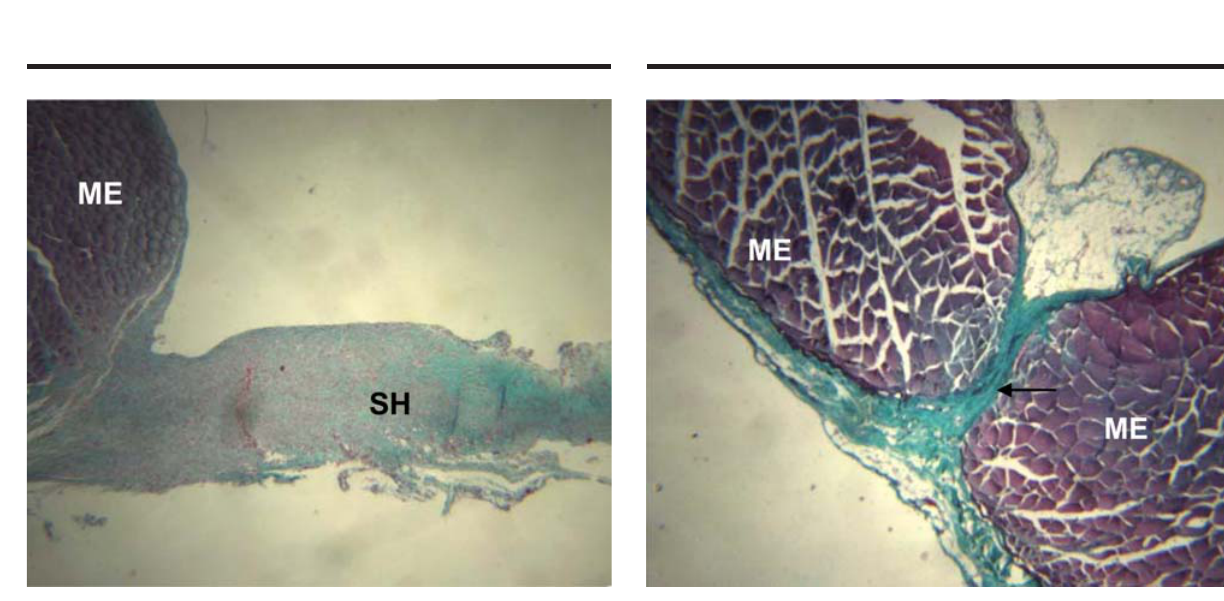
FIGURA 4 - Fotomicrografia do plano músculo-aponeurótico da parede abdominal de rato (subgrupo que recebeu o US por 28 dias), em que se vê a cicatriz na linha alba (seta), constituída por tecido conjuntivo denso, em azul, com o tecido muscular estriado (ME) a cada lado (objetiva de x4,